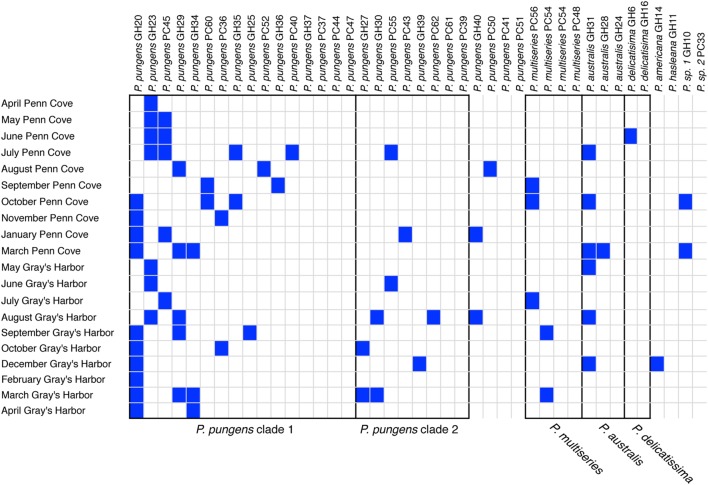
Pseudo-nitzschia – virus infection network. Filled boxes represent infectious crosses. Black outlines delineate groups of hosts that share identical ITS1 sequences, which are labeled underneath.